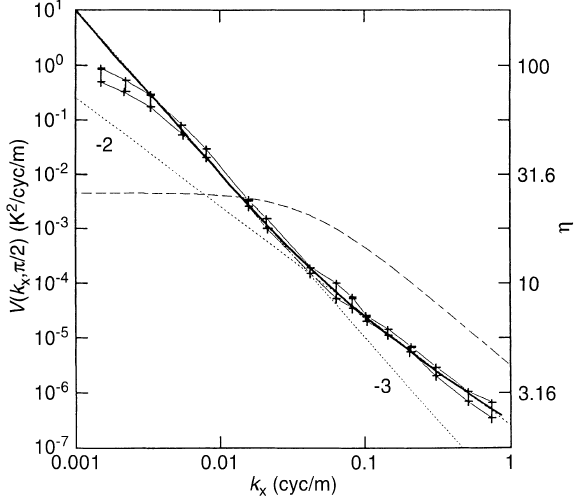
Fig. 8. The comparison of vertical coherence scales (cid:68) Z : the model Fig. 9. The comparison of the model horizontal spectrum ( thick, solid ( solid line ) and the measurements (Dugan, 1984) ( boxes ). The model line ) with the measurements by Dugan (1984) ( hatched stripe ). Dotted dependence (cid:68) Z on k 0 (cid:136) k x = 2 (cid:112) was obtained by the numerical solution x lines are the power-law functions with slopes (cid:255) 2 and (cid:255) 3. The dashed of the equation (cid:137) Coh (cid:133) k x ; (cid:68) Z ; (cid:112) = 2 (cid:134)(cid:138) 2 (cid:136) 0 : 5 and Eqs. (22), (25), (26) line is the dependence of anisotropy coe(cid:129)cient (cid:103) on k 0 with anisotropy coe(cid:129)cient Eq. (28), and GE spectrum Eq. (18). Dashed lines are the hyperbolas (cid:103) k x (cid:68) Z (cid:136) 1 : 078 at di(cid:128)erent (cid:103) , 0 0 numbers are the values of (cid:103) 0